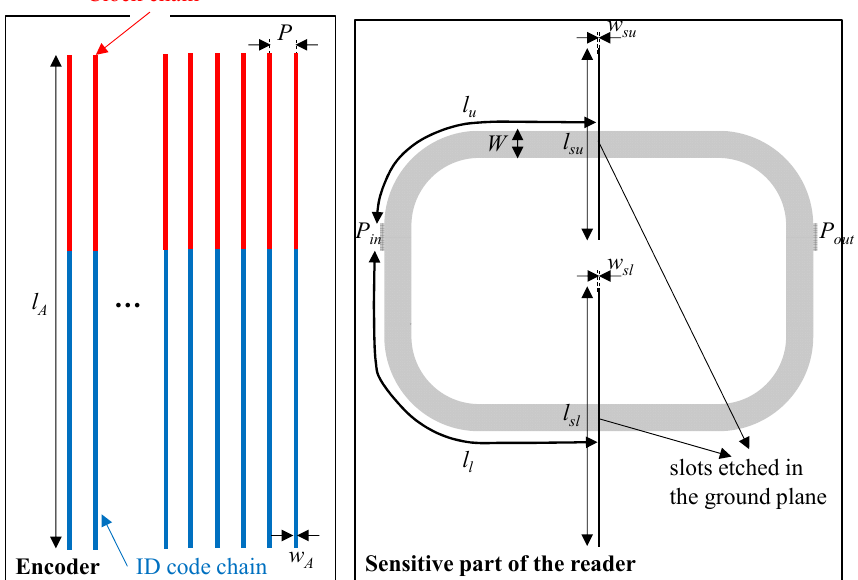
Figure 3. Layout of the designed splitter / combiner structure loaded with a pair of slots and series gaps. Dimensions (in mm) are W = 3.40, l su = 24.1, w su = 0.20, l sl = 32.5, w sl = 0.20, l u = 33.6, l l = 44.7, l A = 62.6, w A = 0.40, and p = 3.40.